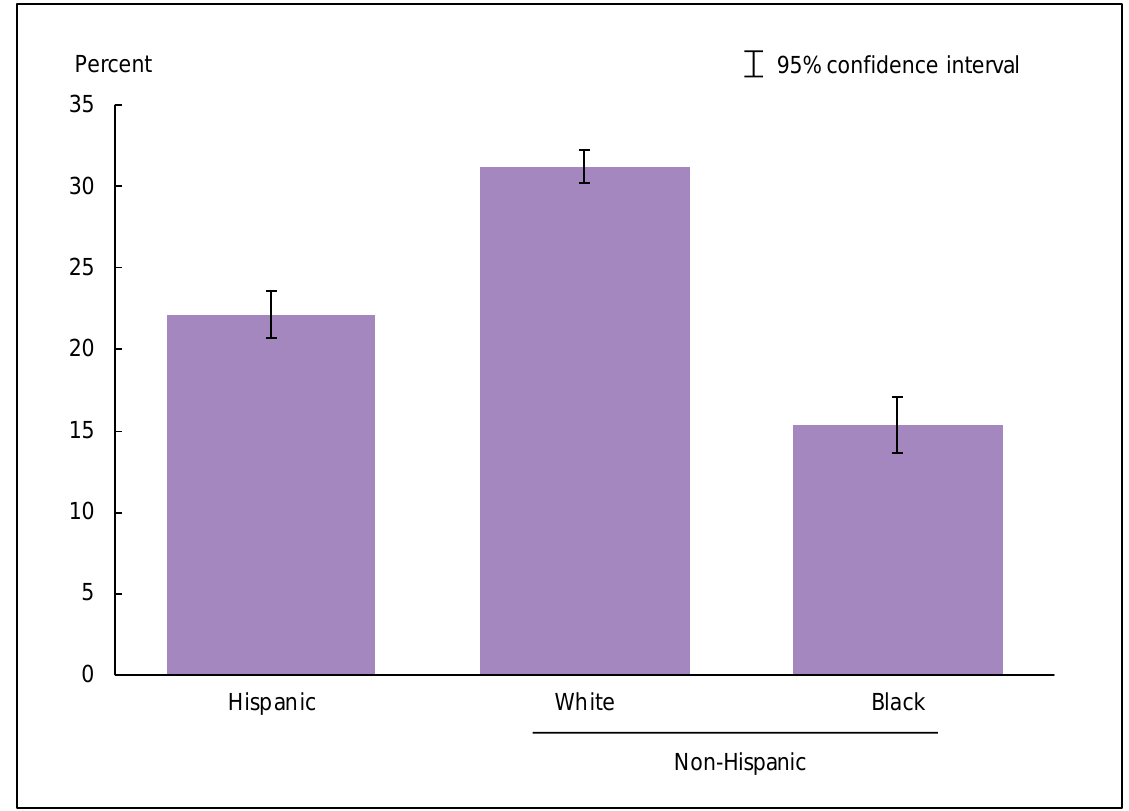
Figure 9.3. Age-sex-adjusted percentage of adults aged 18 and over who had at least 1 heavy drinking day in the past year, by race and ethnicity: United